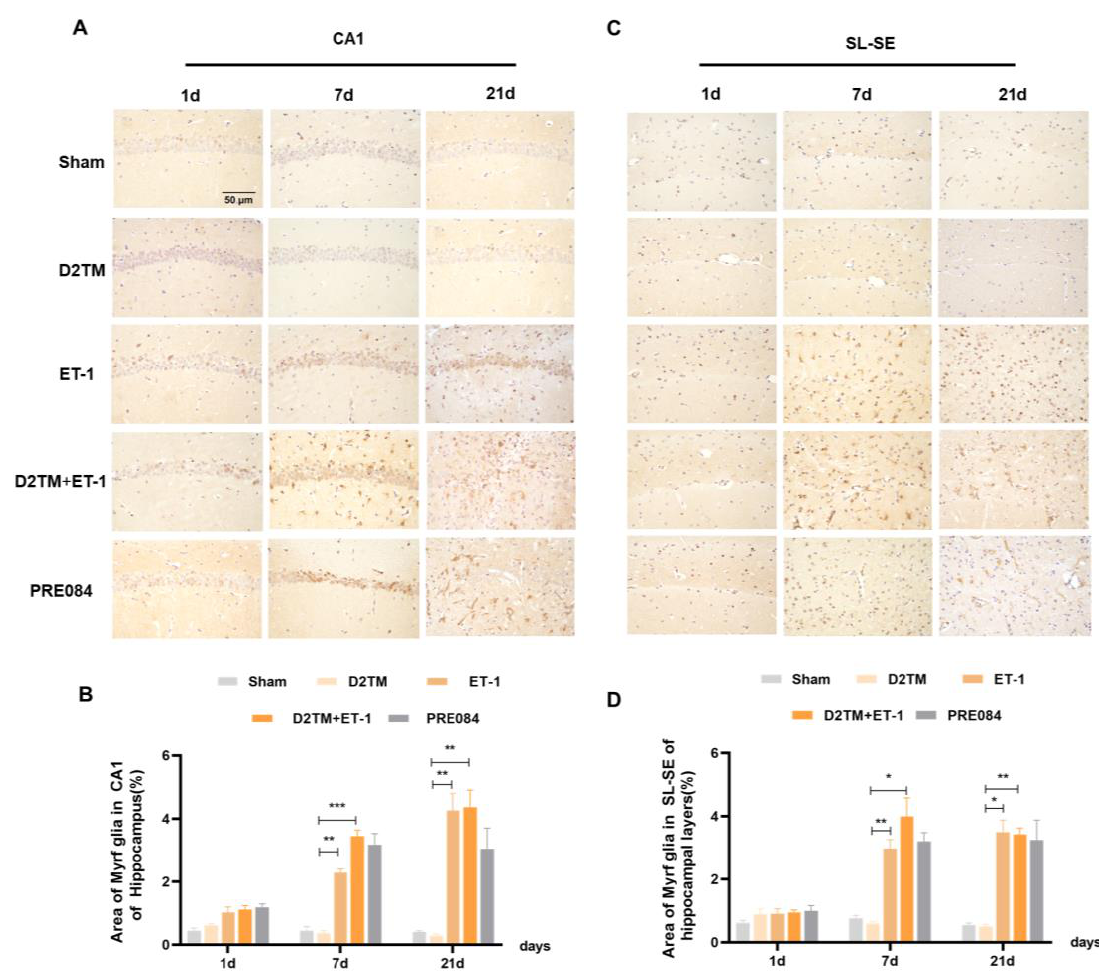
Figure 7. Sigma-1 receptor activation regulated Myrf expression in stroke in diabetic mice. ( A , C ) Myrf immunohistochemistry was performed to detect oligodendrogenesis in the CA1 and the SL–SE hippocampal layers at 1, 7, and 21 d after ET-1 injection. ( B , D ) Quantification of the area of the Myrf-immunostained cells in the CA1 and SL–SE of the hippocampus. n = 4–5/group. Scale bars = 50 µ m. * p < 0.05, ** p < 0.01, *** p < 0.001.